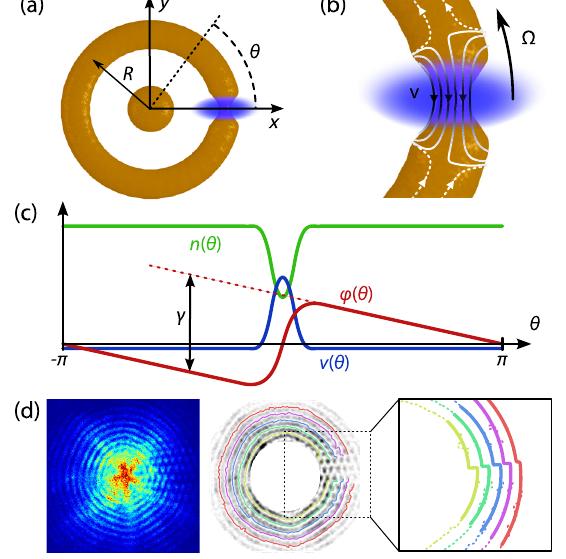
FIG. 2. (a) Schematic of the atoms in the trap with a weak link applied. The coordinate system used throughout is shown; θ ¼ 0 corresponds to the ˆ x axis. (b) A close-up of the weak-link region. When the weak link is rotated at Ω , atoms flow through the weak link (solid) and around the ring (dashed) as shown by the stream lines. Larger velocities along the stream lines correspond to darker lines. (c) The resulting density n ð θ Þ , velocity v ð θ Þ , and phase ϕ ð θ Þ as a function of angle, with the phase drop γ across the weak link shown. (d) Method of extracting the phase from an interferogram (left). First, we trace the interference fringes around the ring (center), and then we fit the discontinuity across the region where the barrier was